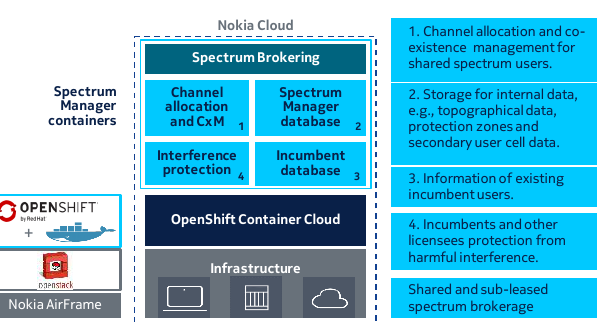
Figure 7. The LSAevo trial environment.